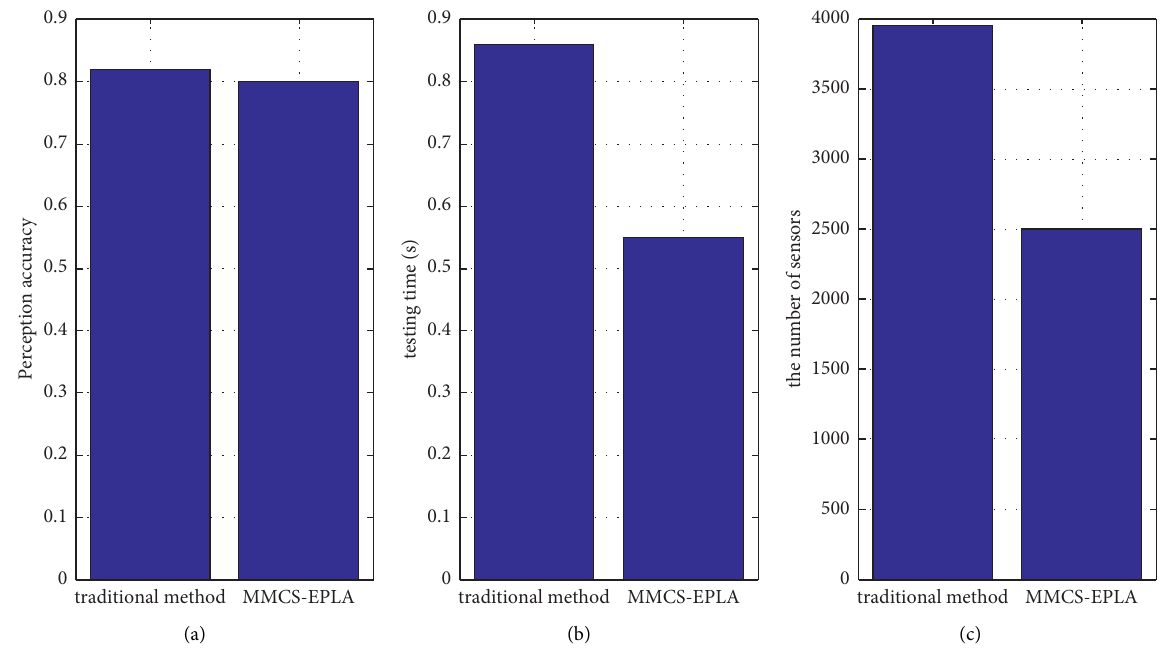
Figure 6: Performance comparison between MMCS-EPLA and traditional method in MHEALTH data set.